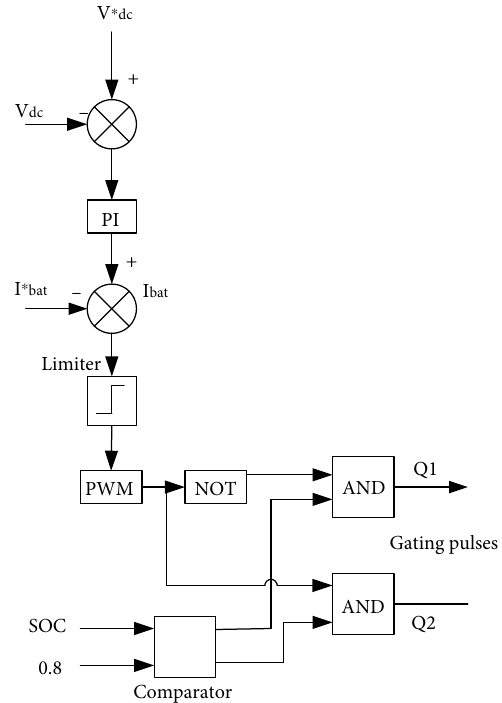
Figure 7: The DC-DC converter controller ’ s e ffi ciency of a proposed multiconverter are shown through simulations or hardware tests [9].